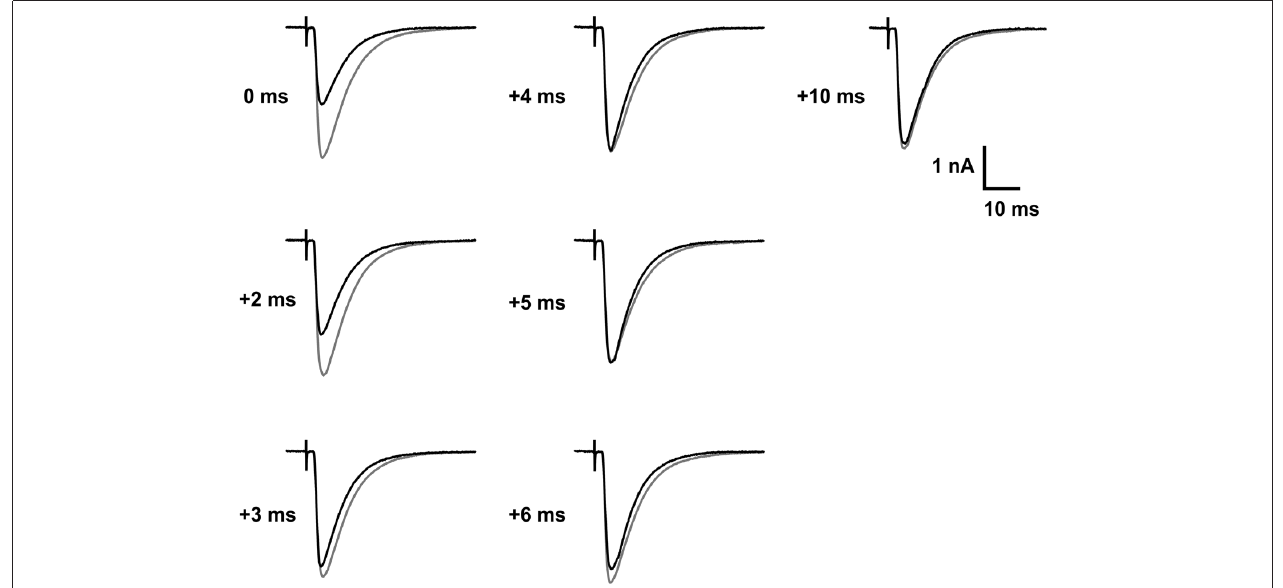
FIGURE 5 | Timed inhibition of CF-PC EPSC by photorelease of γ - D GG. Each panel shows the second EPSCs of a pair separated by 150 ms, the control (gray traces) and 30 s later with photorelease of 0.74 mM γ - D GG (black traces), released in a 1 ms flash from the indicated times relative to the stimulus. The bath contained 5.9 mM MNI-caged γ - D GG. At early times (0 and 2 ms delay from the stimulus) inhibition is comparable to steady-state inhibition. At later times of γ - D GG release (triggered at 3–10 ms) the EPSC approaches the control EPSC peak and only the decay is affected. Age 14 days, − 50 mV, 24 ◦